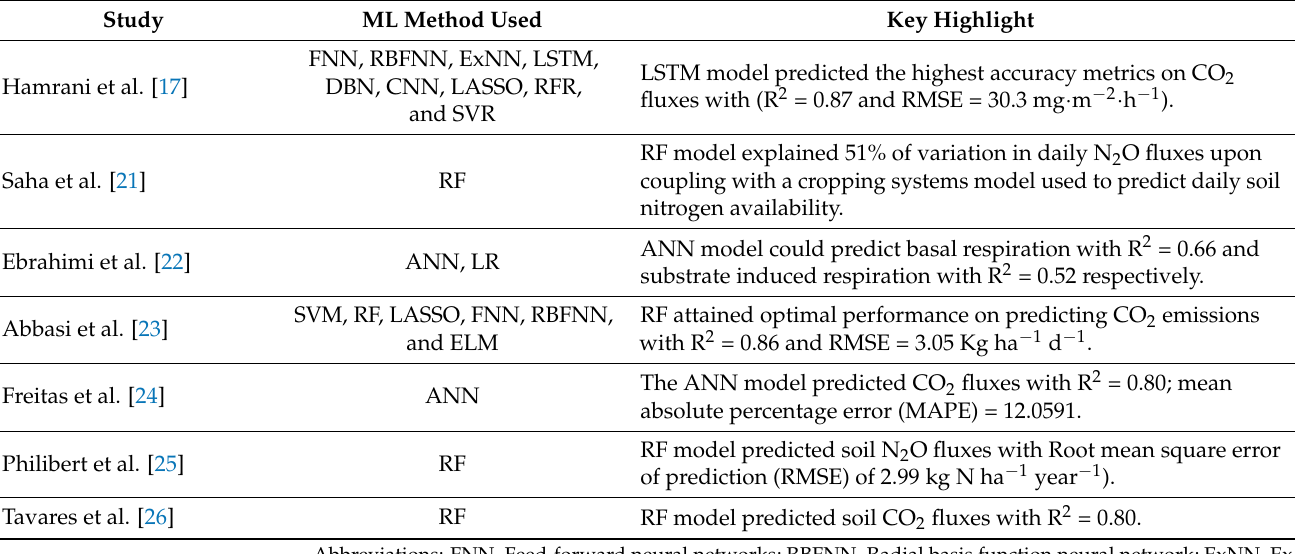
Table 1. Summary of relevant studies that used machine learning (ML) to simulate soil